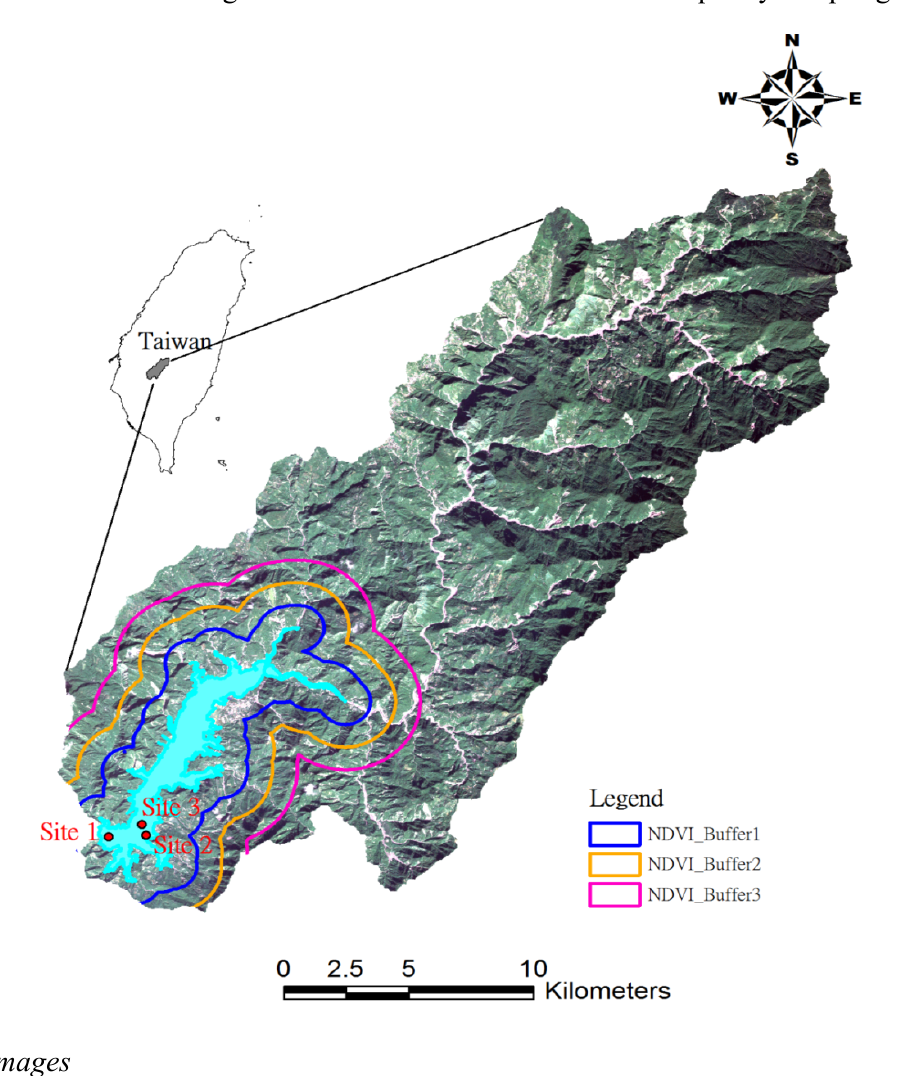
Figure 1. Location of Tseng-Wen Reservoir watershed and water quality sampling